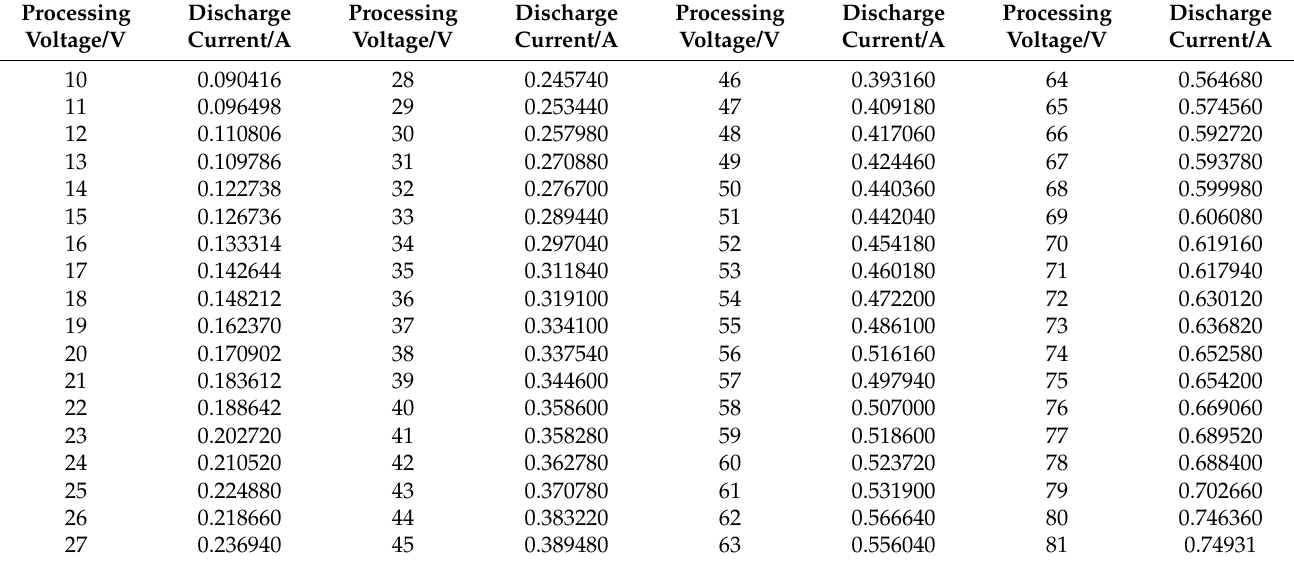
Table 2. Discharge current at different voltages.